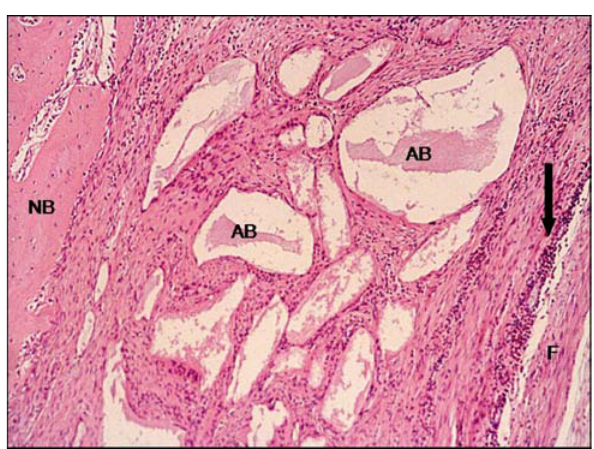
FIGURE 3 - Photomicrograph of a defect of Group A at 30 days after surgery. Notice the particles of bovine inorganic bone (AB) surrounded by connective tissue with a large number of cells and some inflammatory reaction areas. bone (NB). HE, 10x